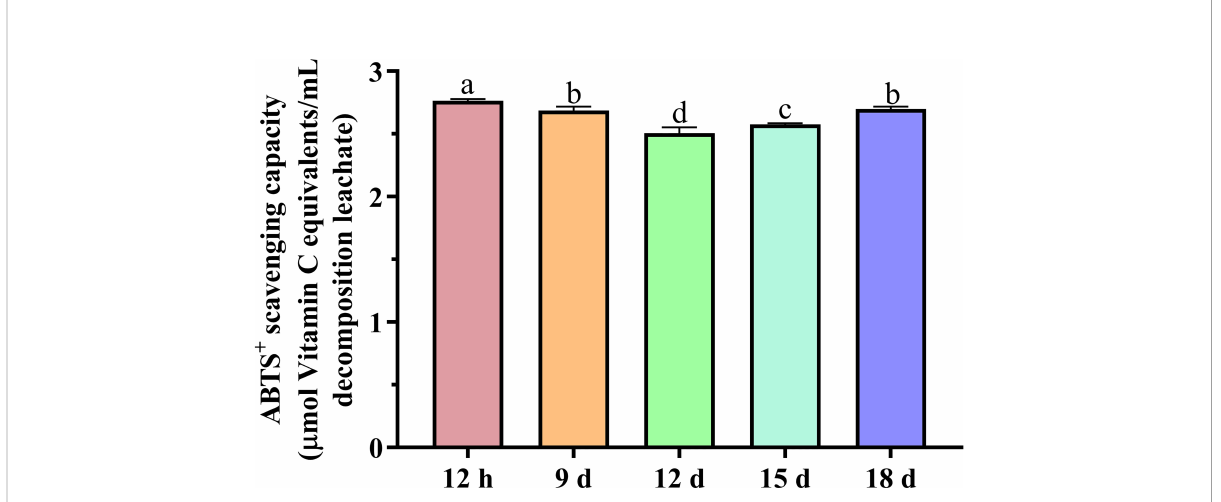
FIGURE 5 ABTS + scavenging capacity of the decomposition leachates at different decay times. Different letters denoted signi fi cantly different ( P < 0.05) among different decomposition leachates of decay durations. Bars represent three repetitions ± SD.